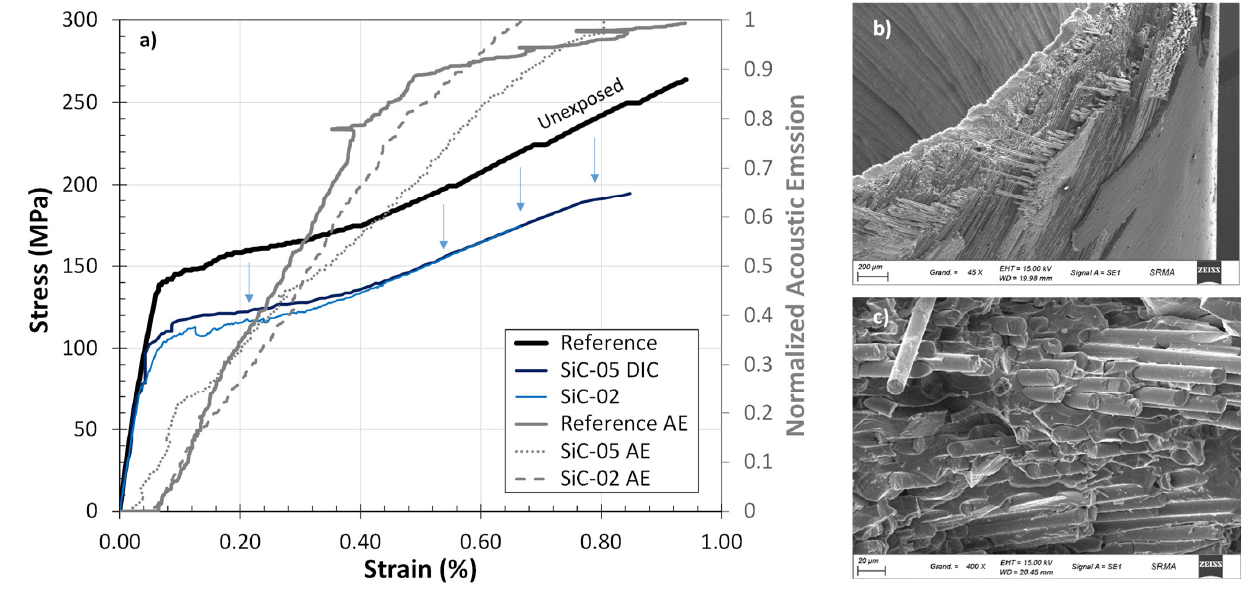
Figure 11. ( a ) Uniaxial tensile stress-strain behavior measured on SiC-02 and SiC-05 samples at ambient temperature after 1 h isothermal oxidation in steam at 1700 °C. The reference stress-strain curve measured on the pristine material is given for comparison. ( b , c ) Representative fracture surface SEM images observed at different magnitudes on sample SiC-02. Table 2. Test characteristics, post-test examinations conducted, and selected results.